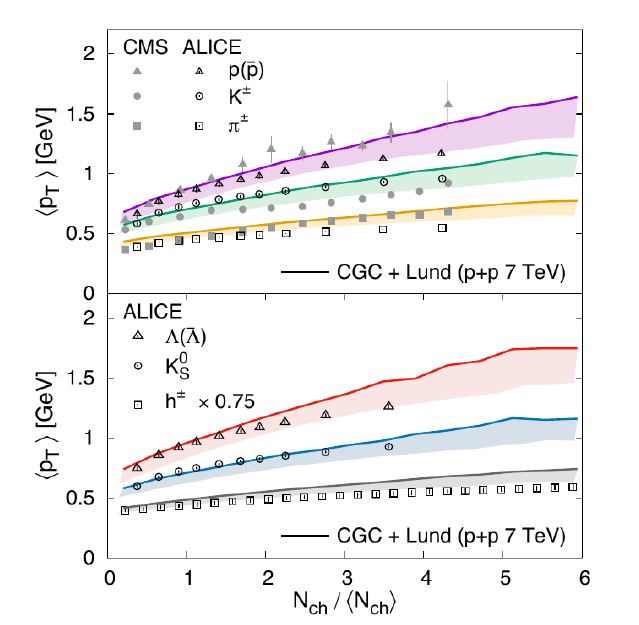
Figure 24. IP-Glasma predictions for 7 TeV center of mass energies pp collisions for the multiplicity dependence of ( top ) unidentified charged hadrons, ( center and bottom ) identified hadrons. Figures from the works in [173,177].